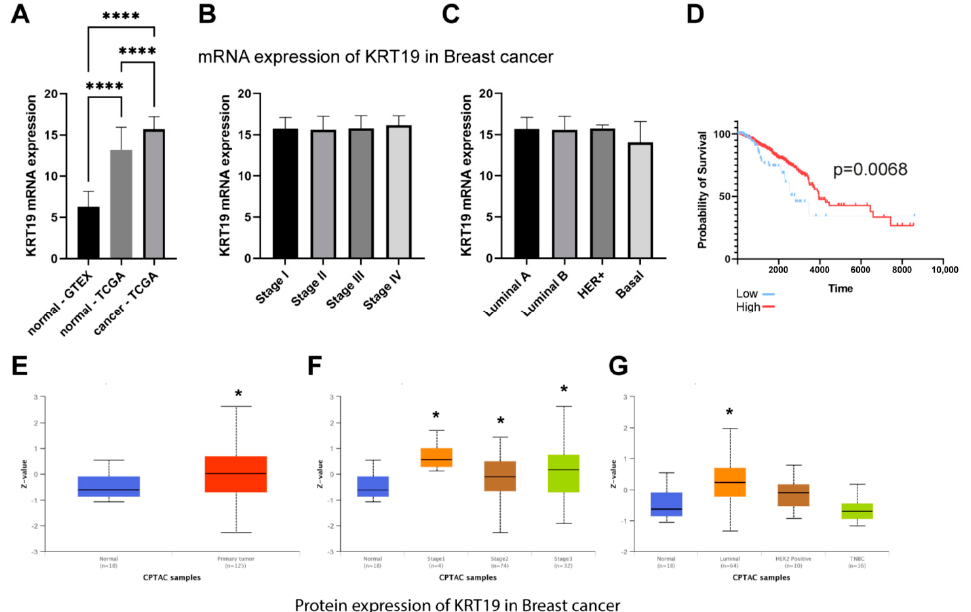
Figure 7. The expression of KRT19 (CK19) mRNA in GTEx and TCGA breast cancer cohort. ( A ) KRT19 expression in normal and tumor tissue, ( B ) KRT19 expression in different tumor stages, ( C ) The comparison of KRT19 expression among PAM50 subtypes. ( D ) Overall survival of TCGA breast cancer cohort. Lower KRT19 (CK19) mRNA expression is associated with better outcomes for breast cancer patients. The survival curves were compared using Log-rank (Mantel-Cox) test. p < 0.05 was considered significant. The analysis of KRT19 proteins in breast cancer patients (CPTAC cohort). ( E ) KRT19 expression in normal and tumor tissue, ( F ) KRT19 expression in different tumor stages, ( G ) The comparison of KRT19 expression among PAM50 subtypes. The asterisks point to statistically significant differences comparing to the normal group (Kruskal-Wallis test with Dunn’s multiple comparison test). ‘*’ p ≤ 0.05, ‘****’ p ≤ 0.0001